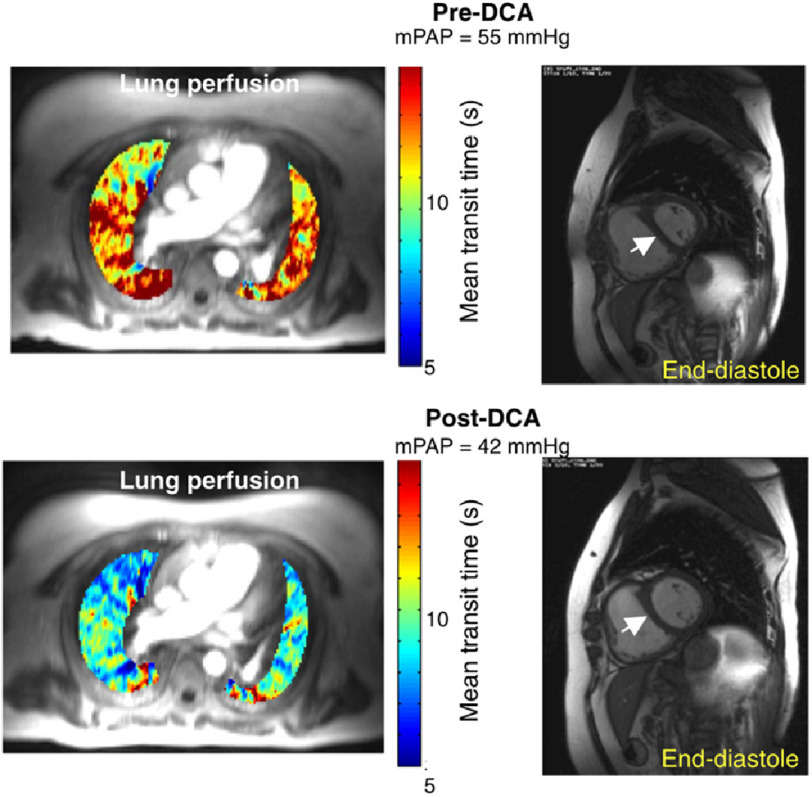
Functional imaging biomarkers in two DCA responders.Magnetic resonance showing gadolinium transit time before and after DCA and resolution of the D-shaped septum (arrow) in the heart of a study patient. Note the color scale of the gadolinium: blue indicates short transit time and increased perfusion; yellow/red indicates a long transit time and little/no perfusion at baseline. Reproduced with permission from Ref. [20].